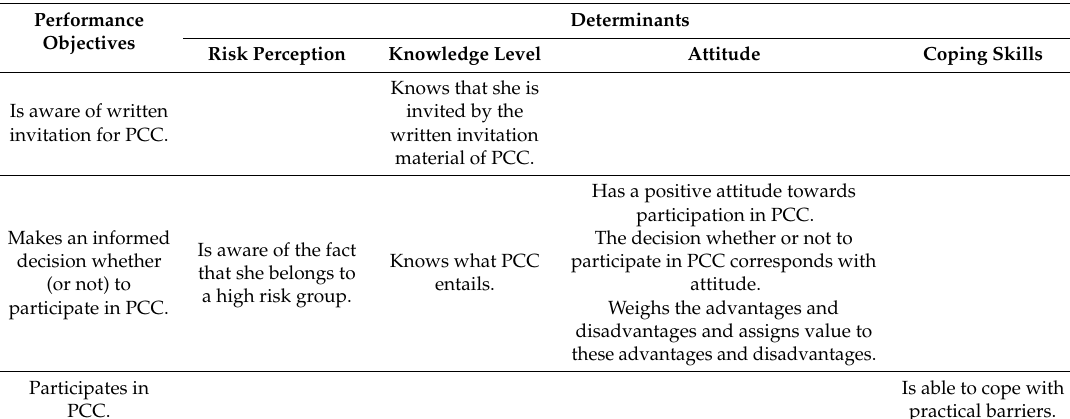
Table 1. Performance and change objectives.